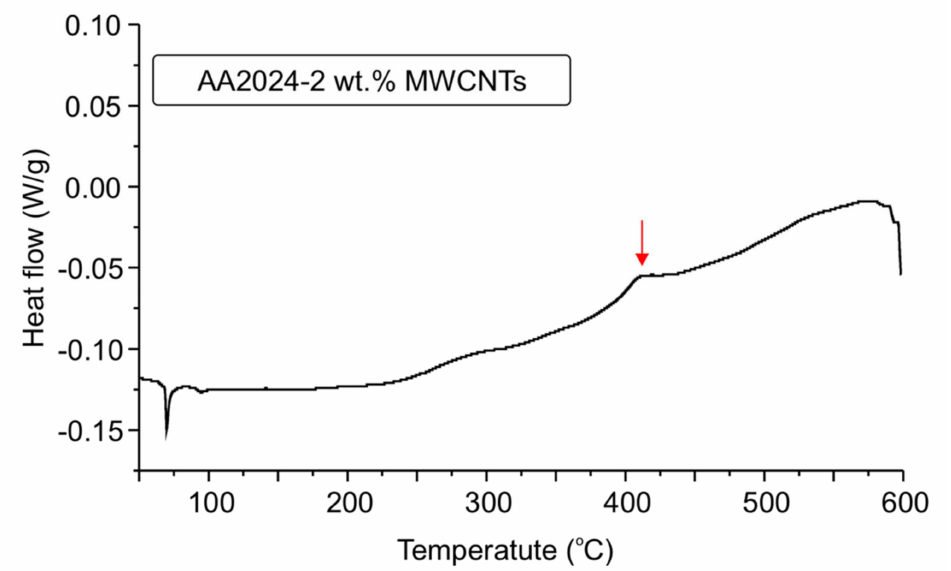
Figure 3. DSC curve for AA2024-2 wt.% MWCNT composite